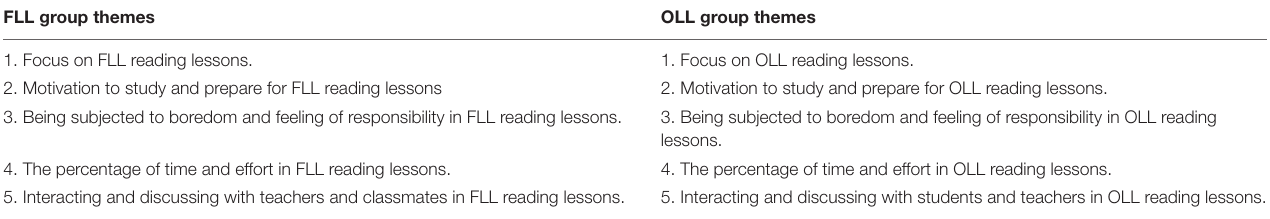
TABLE 3 | Questionnaire themes that emerged from the first qualitative